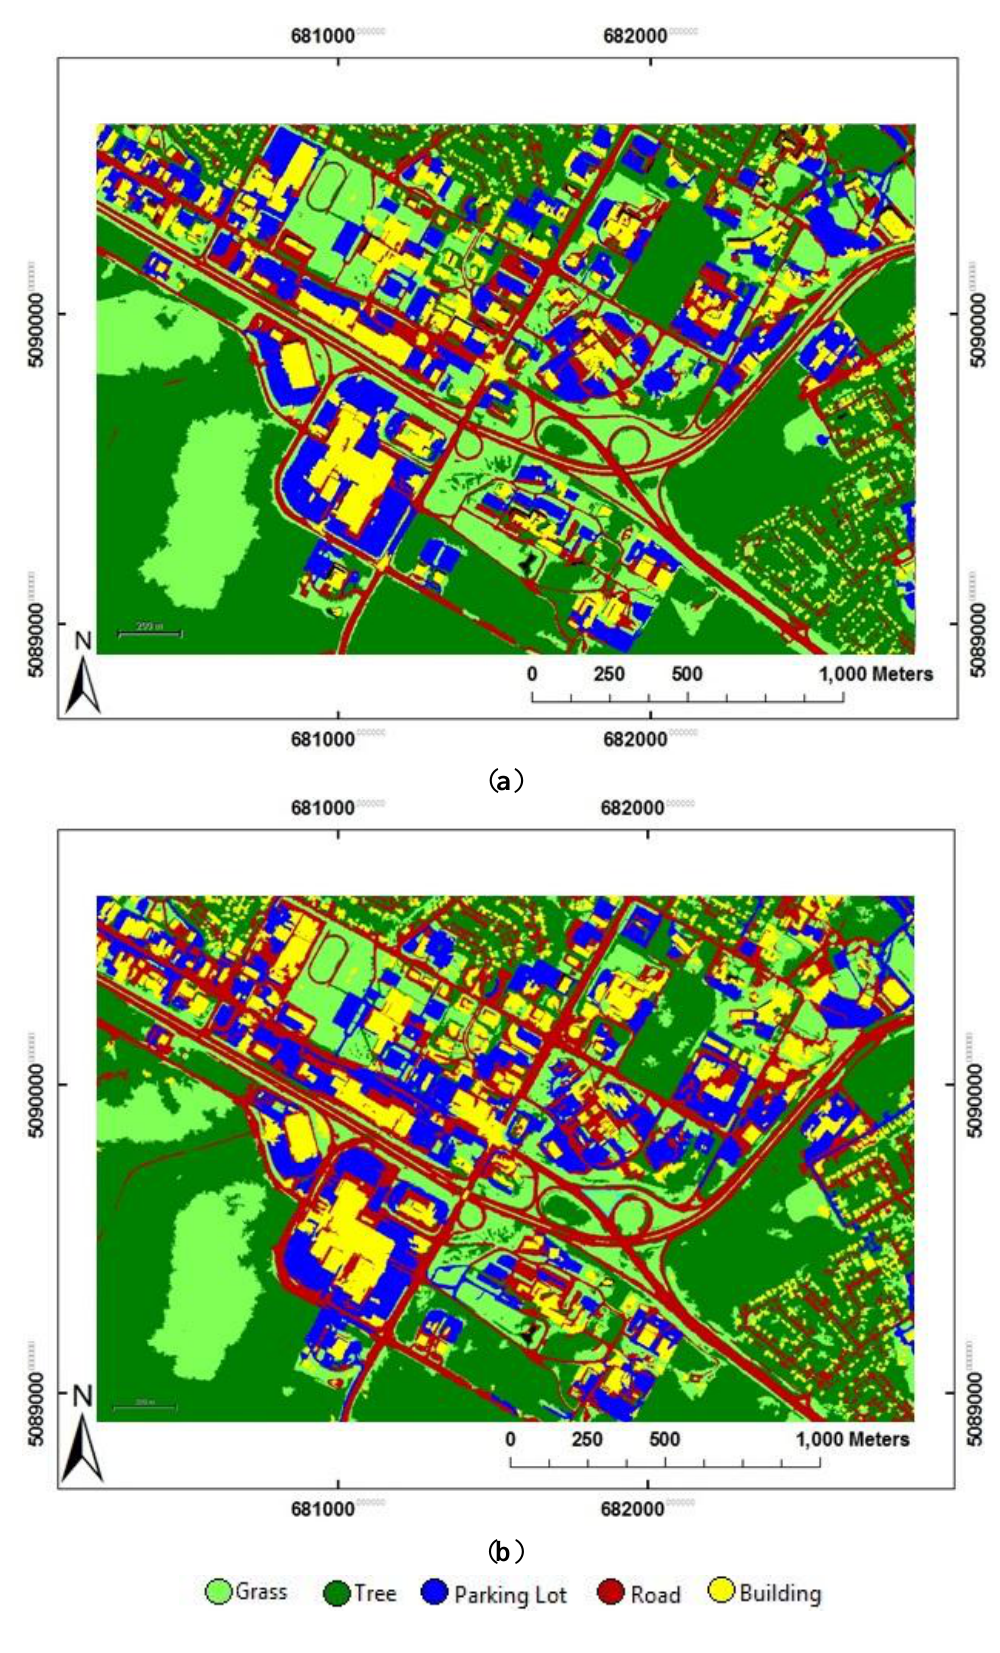
Figure 6. Hierarchical object-based classification results of ( a ) QB and ( b ) IK Test